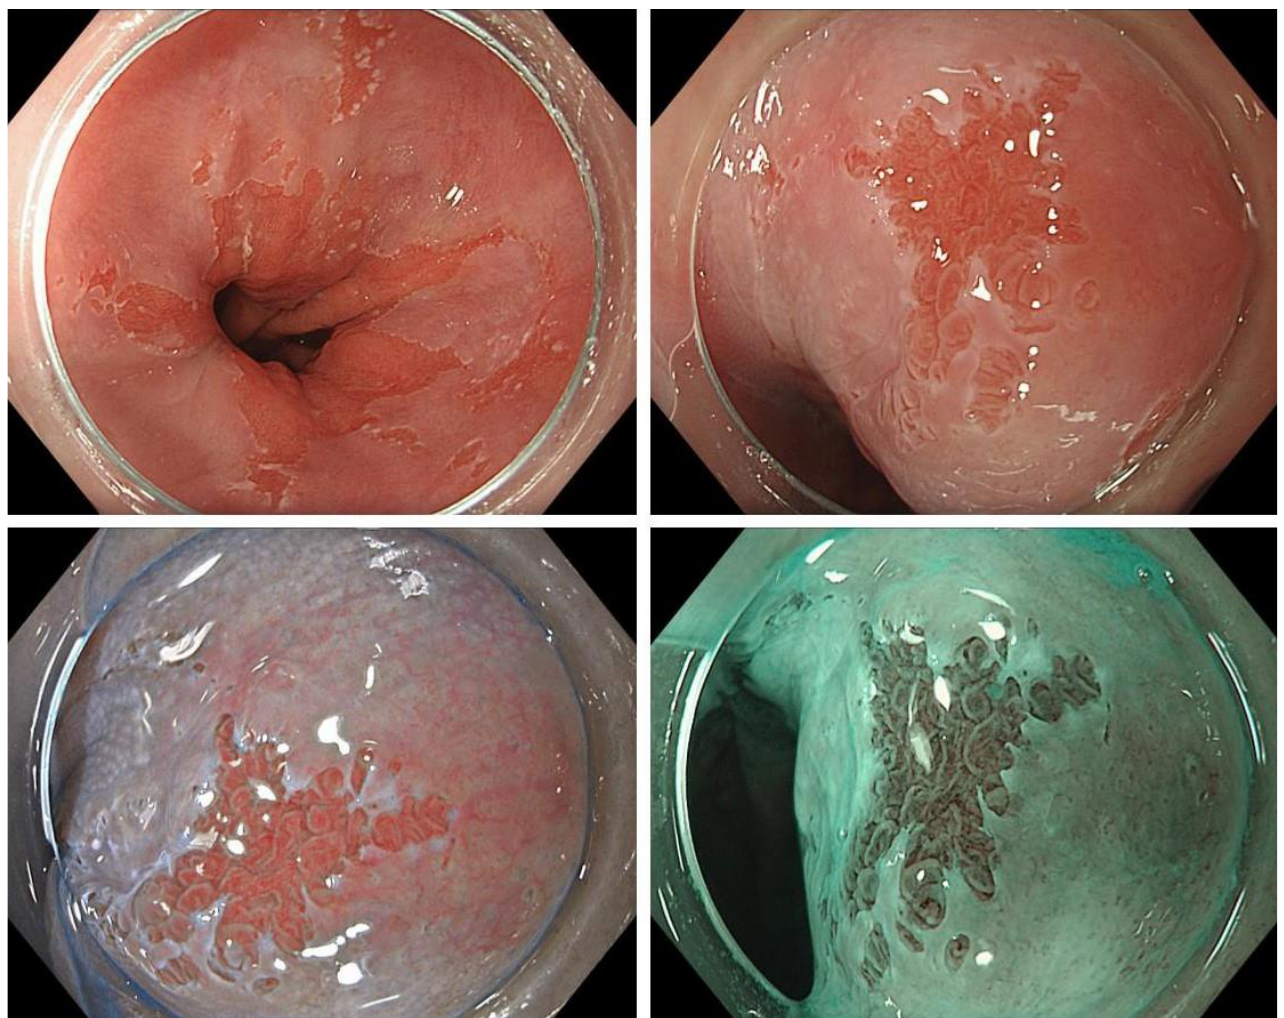
Figure 1. Example of a small Barrett ’ s adenocarcinoma detected during surveillance endoscopy ( top left : overview of the transition zone; top right : close-up view (HD-WLE); bottom left : close-up view (texture and color enhancement imaging/TXI); bottom right : close-up view, narrow-band imaging (NBI) mode). Images from the Olympus Evis X1 endoscopy system.